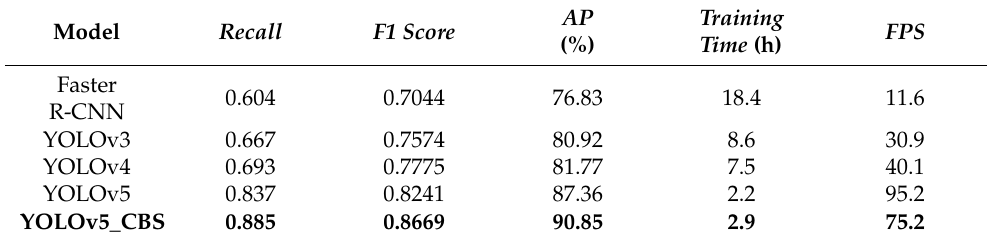
Table 7. Performance comparison of models on private